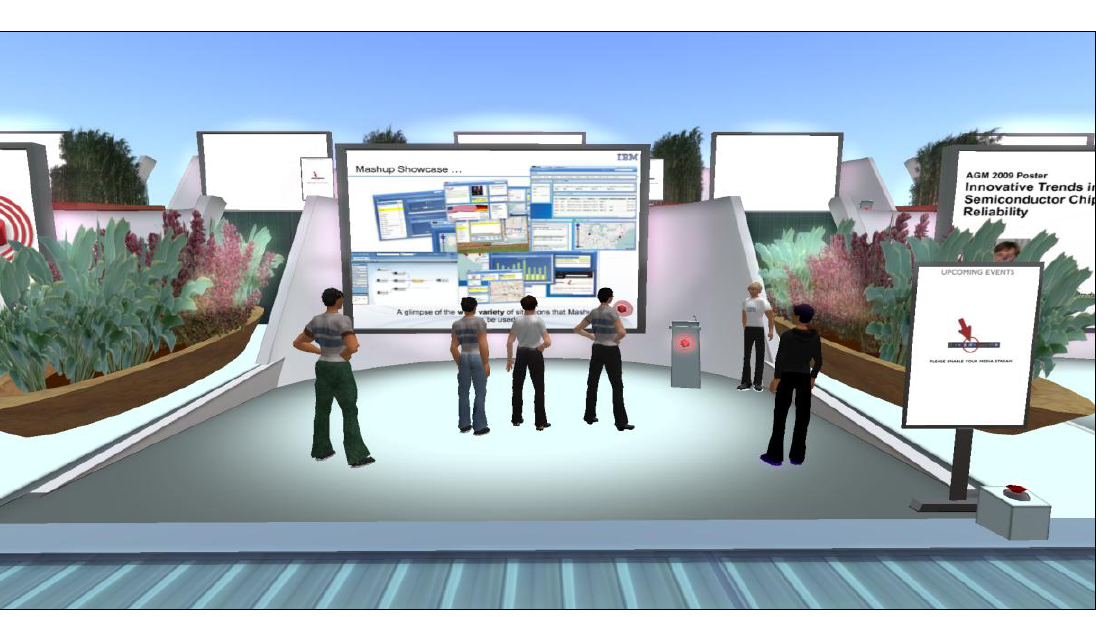
Figure 7. A Poster Bay. The space marked by the shading and the planters is sound